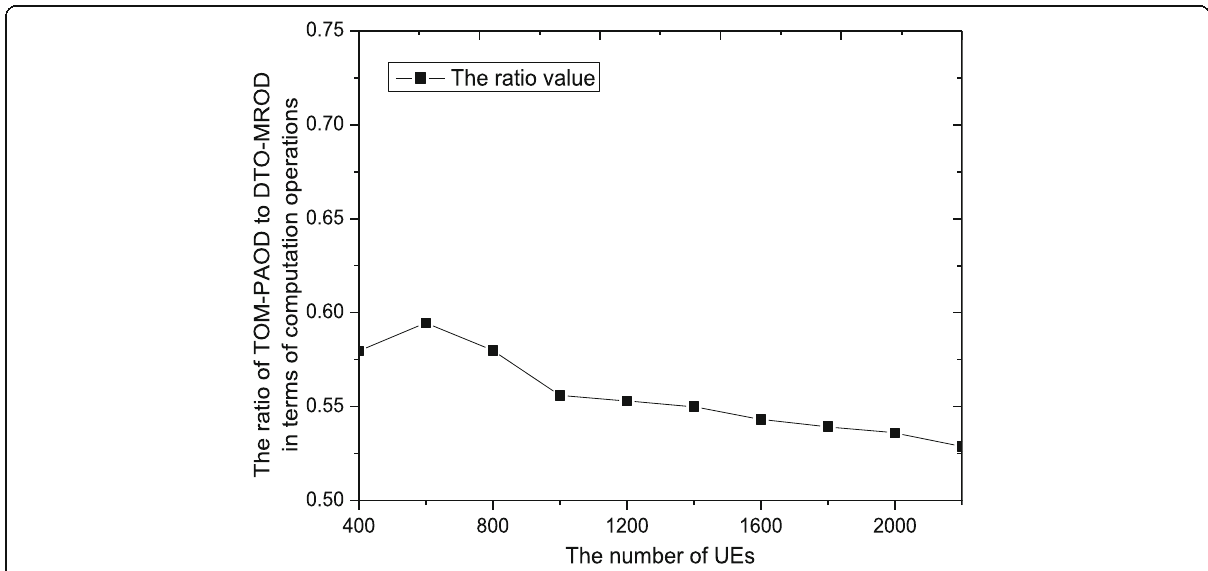
Fig. 8 Variation trend of the ratio with the number of UEs in the given